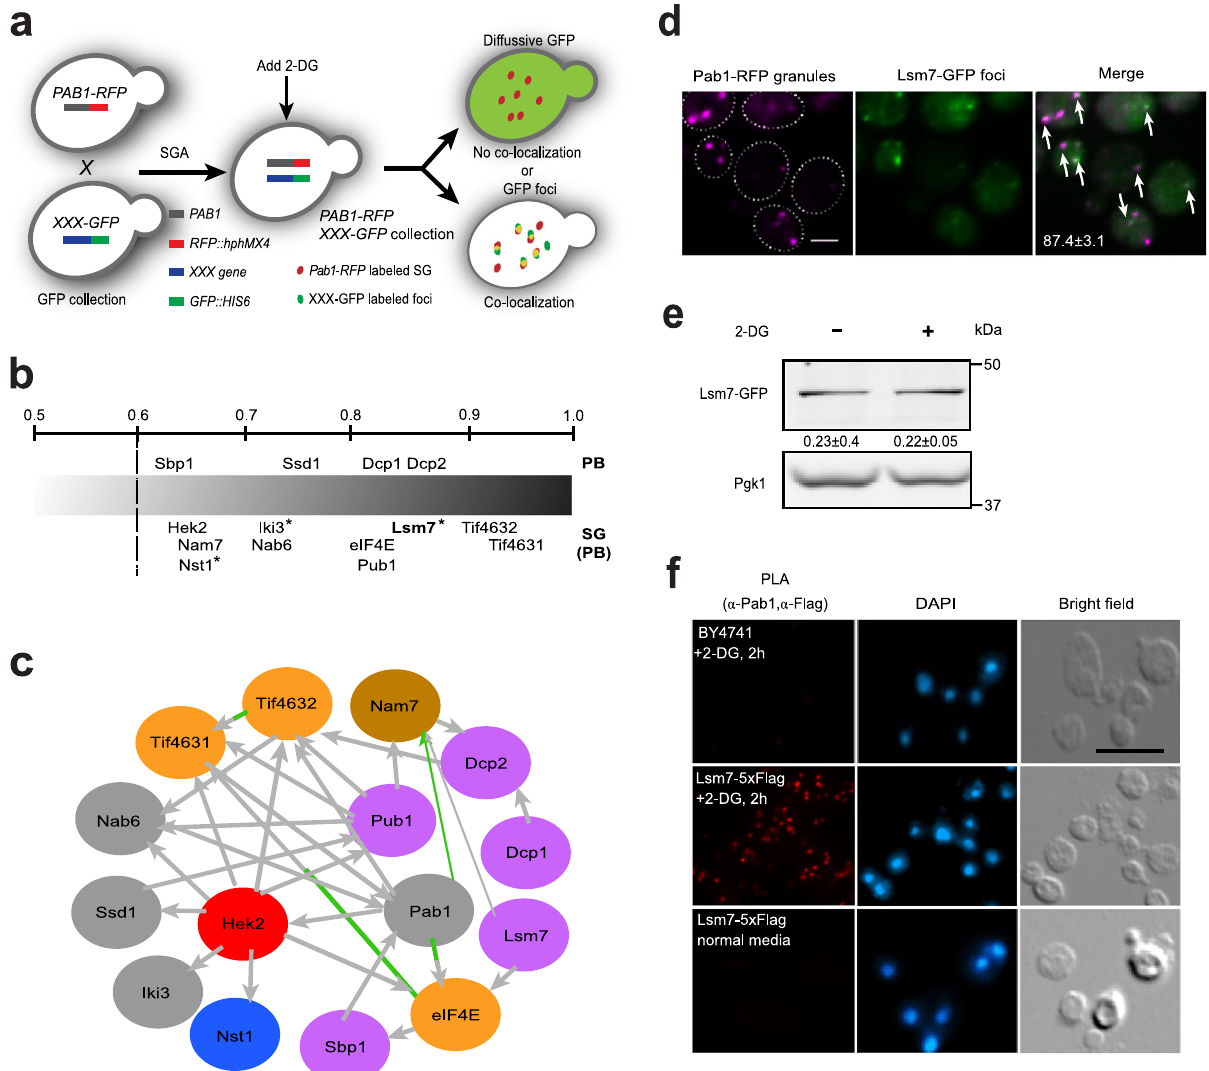
Fig. 1 A global survey identi fi es Lsm7 as a SG component. a Work fl ow for the SG components screen under 2-DG treatment. b Fractional co-localization of GFP foci with Pab1-RFP granules based on manual fl uorescence microscopic studies. Proteins that are known PB components are indicated above the gradient, and proteins that are reported as SG components (or PBs) are shown below the gradient. Previously unreported SG components are marked with an asterisk. Numbers above the gradient represent co-localization rate (%) of GFP foci with Pab1-RFP granules. Four biologically independent experiments were examined and >200 cells were analyzed for each (mean ± S.D). c Interaction network analysis for the 14 hits that co-localize with SGs together with Pab1 (colored nodes are colored based on their enrichment of Gene Ontology biological processes; gray for metabolism, pink for RNA processing; orange for protein biosynthesis, blue for stress response, brown for DNA metabolism, and red for RNA localization; gray lines indicate physical interactions, and green lines indicate genetic interactions). d Pab1-RFP granules were strongly co-localized with Lsm7-GFP foci (arrow heads indicate the co-localization). Values represent the co-localization rate (%). Scale bar indicates 2 µ m. Three biologically independent experiments were examined and >200 cells were analyzed for each (mean ± S.D). e The Lsm7-GFP protein expression level was not impacted by the addition of 2-DG. Log-phase cells were treated with 400 mM 2-DG for 2 h and subsequently collected for Western blot analysis. Data are representative of three biologically independent experiments. Values are means ± S.D of the arbitrary units (intensity of target bands normalized to Pgk1 levels) for each clone. f Lsm7 proximately associates with Pab1 under 2-DG treatment. WT (BY4741) and Lsm7-5xFlag strains were grown and treated with or without 2-DG. In situ proximity, ligation assay was performed by using antibodies against Pab1 and Flag-tag. The PLA signal was assessed as described in Methods. Scale bar indicates 5 µ m. Three biologically independent experiments were examined and representative images from one experiment are shown. Source data are provided as a Source Data fi